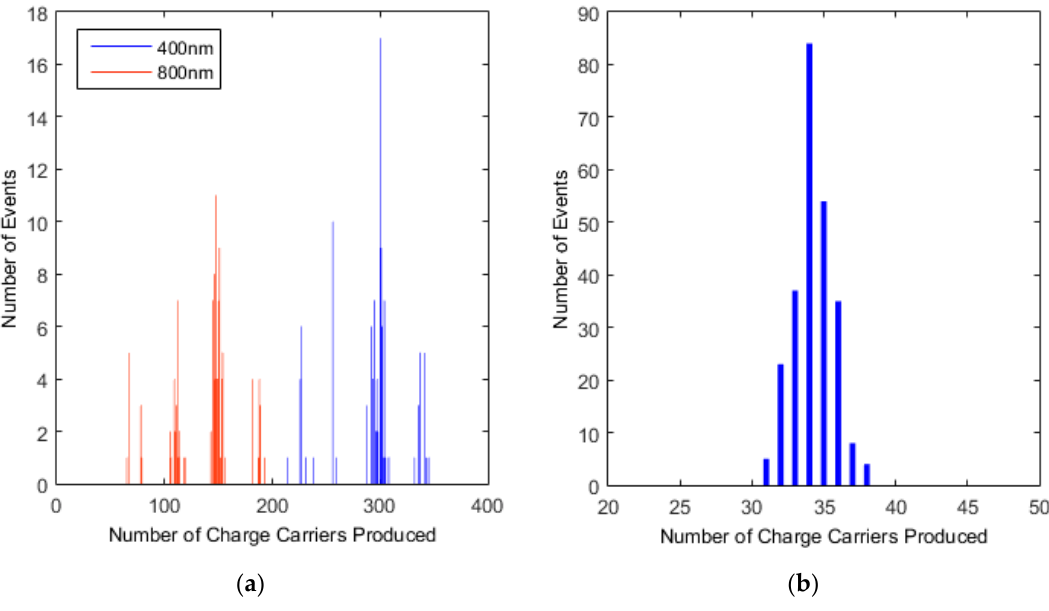
Figure 4. Showing ( a ) the number distribution as a function of photon energy for µ = 100; and ( b ) the distribution of events for λ = 3500 nm photon. µ = 100.